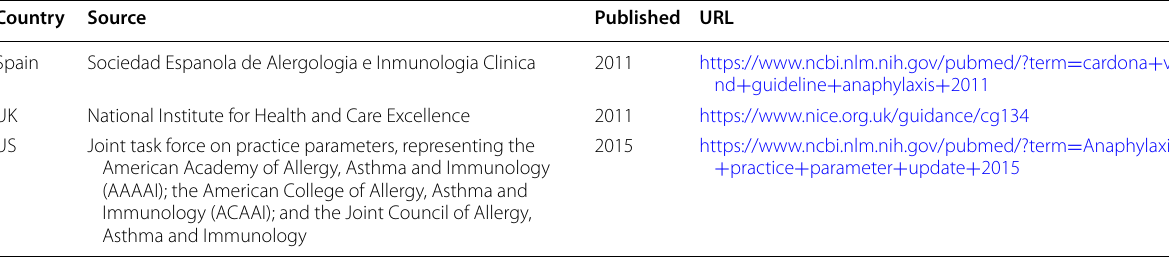
Table 3 National guidelines for the management of